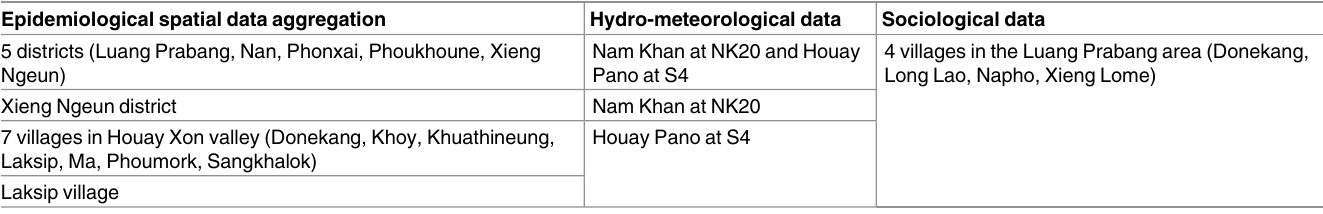
Table 1. Spatial information used to mix epidemiological, hydro-meteorological and sociological datasetsin the Luang Prabang area, Laos. Epidemiological spatial data